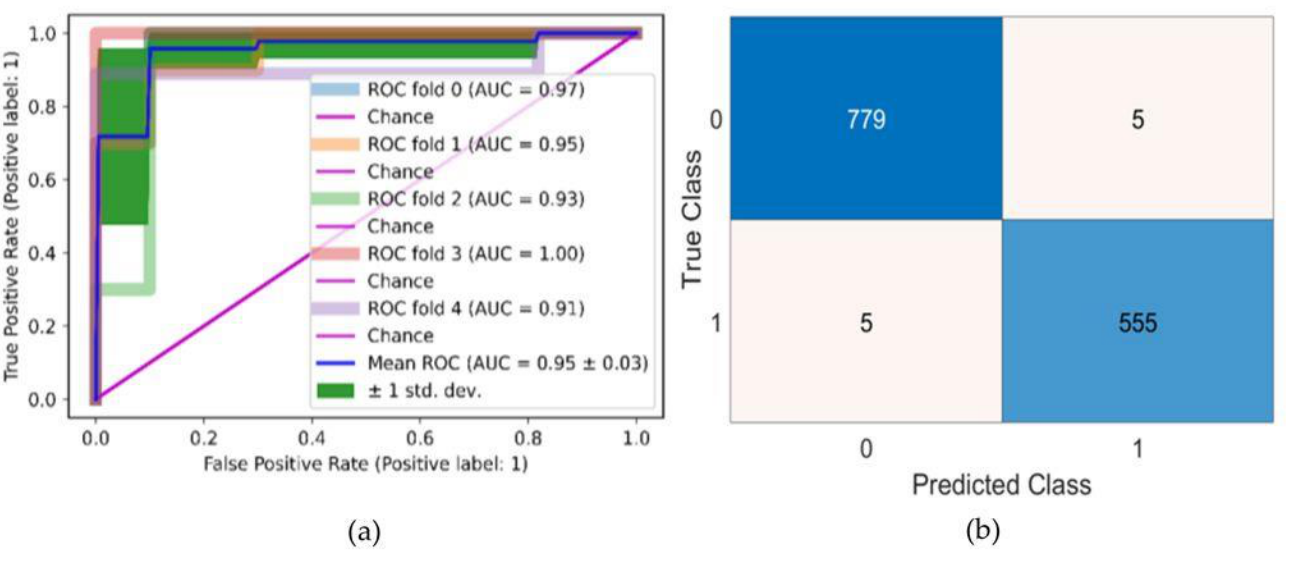
Figure 8. Classification results on MED-NODE ( a ) ROC curve of fine KNN ( b ) confusion matrix of fine KNN. Table 9. Proposed classification model results on PH2.